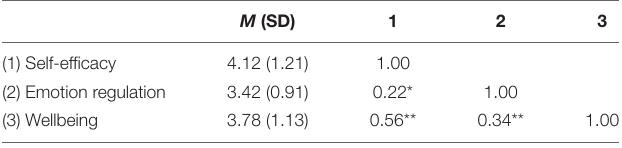
TABLE 2 | Descriptive statistics and